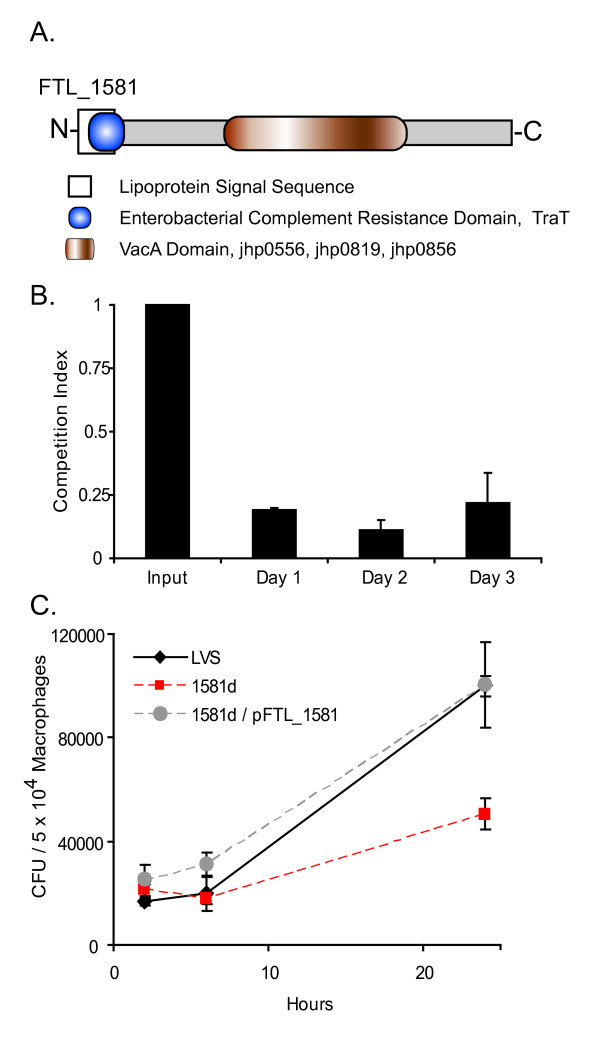
FTL_1581 contributes to F. tularensis LVS virulence. (A) A schematic of FTL_1581 protein is depicted showing domains predicted by PROSITE. (B) Competition studies in the chicken embryo infection model using a mixture of LVS and 1581d (1:1 based on OD600; viable bacteria in the inoculum were quantified by diluting and plating the input). Competition ratios (1581d: LVS) were normalized to the input to account for differences in the inoculum. These ratios were analyzed for statistical significance by Chi square; P < 0.001 at days 1, 2, and 3 post-infection. Data are mean competition ratio ± SEM of three embryos per time point within one experiment and are representative of duplicate experiments. (C) Macrophages were infected with LVS, 1581d, or 1581d/pFTL_1581 and were lysed at the indicated times. Data are mean ± SEM of triplicate wells within one experiment and are representative of four experiments performed using cells from separate donors. Following log transformation, differences in CFU were determined by a Student's t-Test in which P = 0.003 at 24 h.